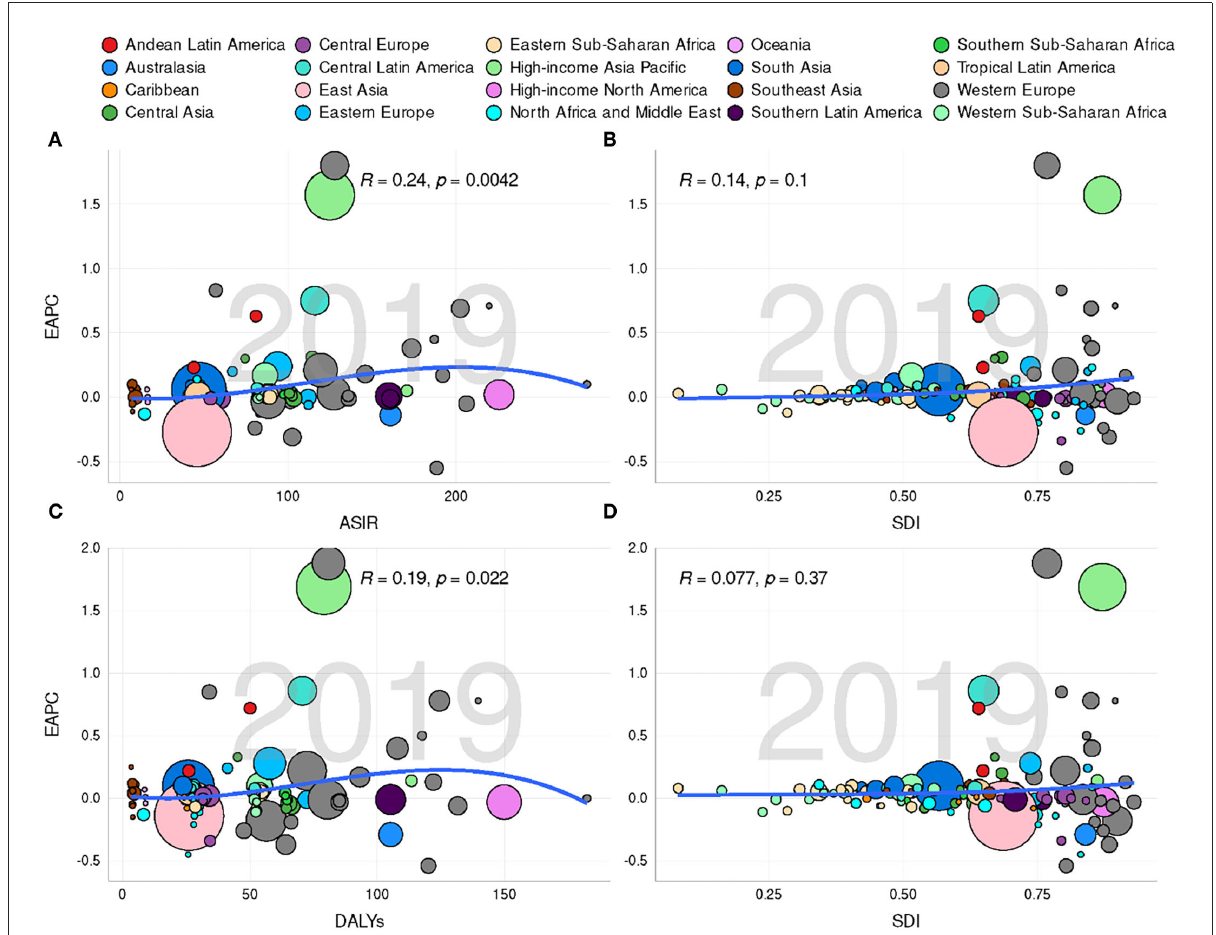
FIGURE4 Correlation between estimated annual percentage changes (EAPCs) and hand osteoarthritis age-standardized rates [ASRs; incidence (A) and DALYs (C) ] in 2019 and socio-demographic index [SDI; incidence (B) and DALYs (D) ] in 2019. Circles represent different countries with their SDI values. The size of these circles reflects the number of hand osteoarthritis subjects. The R - and P -values were calculated by Pearson’s correlation